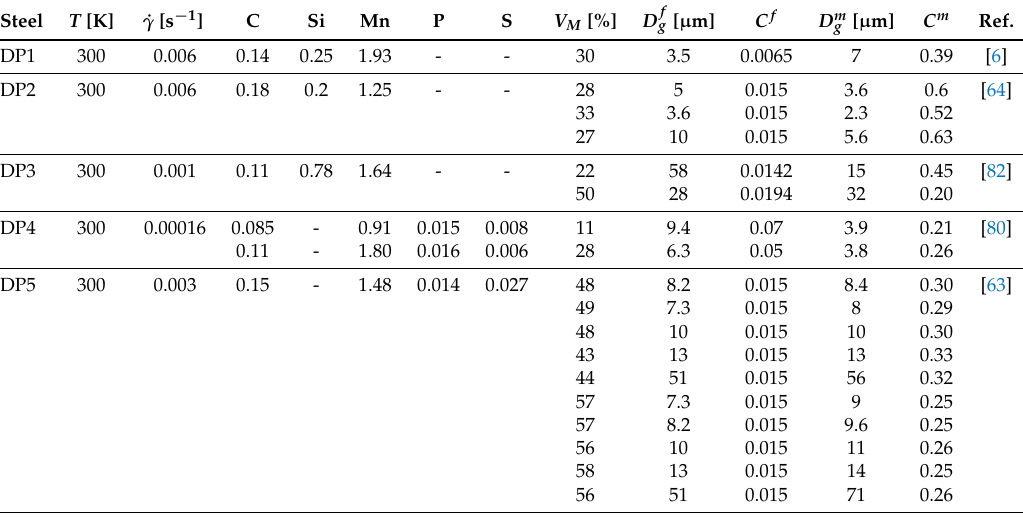
Table 4. Parameters and chemical compositions (in wt%) of DP